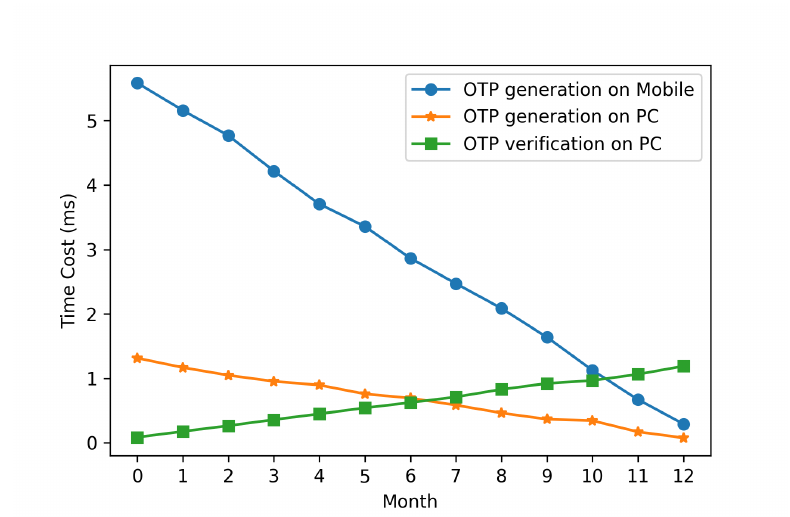
Figure 12. OTP generation and verification time cost of MOTP (valid for one